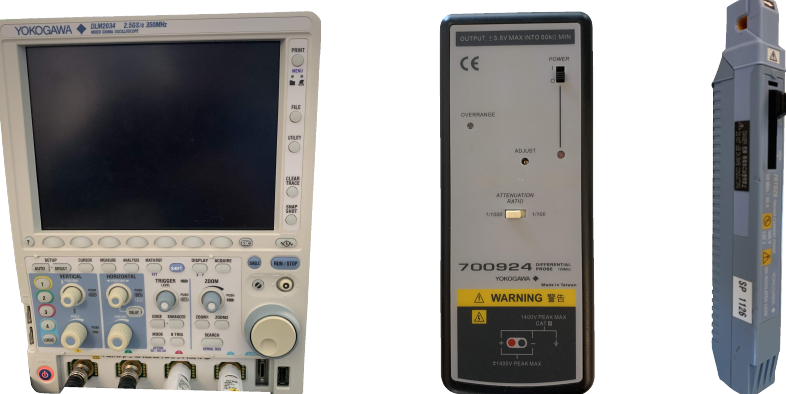
Figure 4. Yokogawa scope, voltage probe and current probe that are used for the data acquisition.